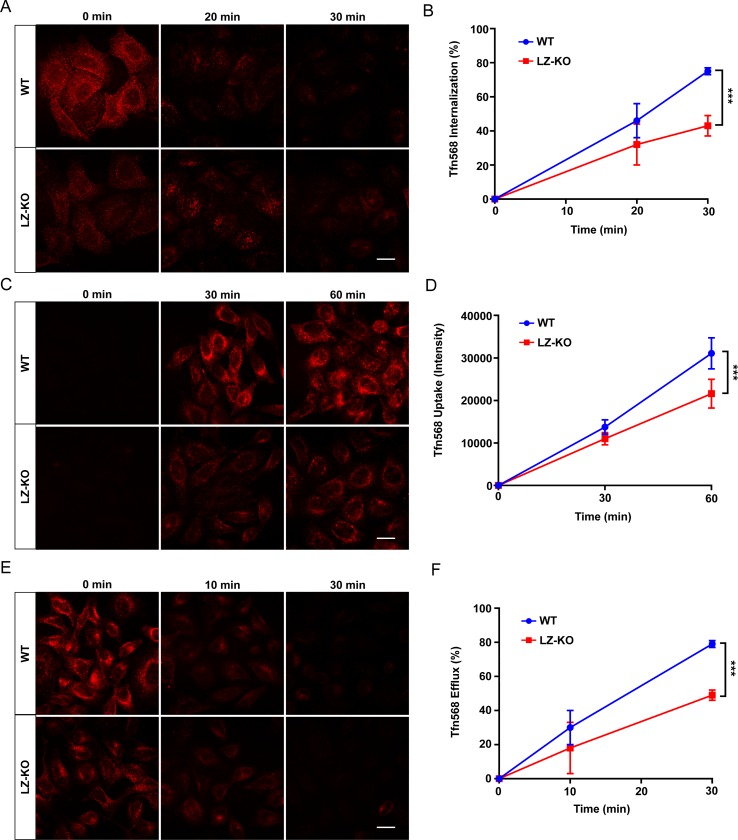
LZTFL1 regulates transferrin internalization, uptake, and efflux.(A) Wild-type and LZTFL1-knockout HeLa cells were loaded with 25 μg/ml of Tfn-568 on ice for 30 minutes, washed, and incubated with complete DMEM for 0, 20, and 30 minutes at 37°C. Time course of Tfn-568 internalization was monitored by loss of fluorescence. Scale bar = 20 μm. (B) Quantitation of Tfn-568 internalization intensity as a percentage normalized with the intensity at time point 0 (100%) in wild-type and LZTFL1-knockout HeLa cells (mean ± SD). Student’s t-test, n>100 cells, ***p<0.0001. (C) Wild-type and LZTFL1-knockout HeLa cells were incubated with 25 μg/ml Tfn-568 for the indicated times, and the Tfn uptake level was measured by the accumulation of Tfn-568. Scale bar = 20 μm. (D) Quantitation of Tfn-568 accumulation in wild-type and LZTFL1-knockout HeLa cells (mean ± SD). Student’s t-test, n>100 cells, ***p<0.0001. (E) Wild-type and LZTFL1-knockout HeLa cells were loaded with 25 μg/ml Tfn-568 for 30 minutes, washed, and incubated with complete DMEM for the indicated times. Time course of Tfn-568 efflux was monitored by loss of fluorescence. Scale bar = 20 μm. (F) Quantitation of Tfn-568 efflux intensity as a percentage normalized with the intensity at time point 0 (100%) in wild-type and LZTFL1-knockout HeLa cells (mean ± SD). Student’s t-test, n>100 cells, ***p<0.0001.